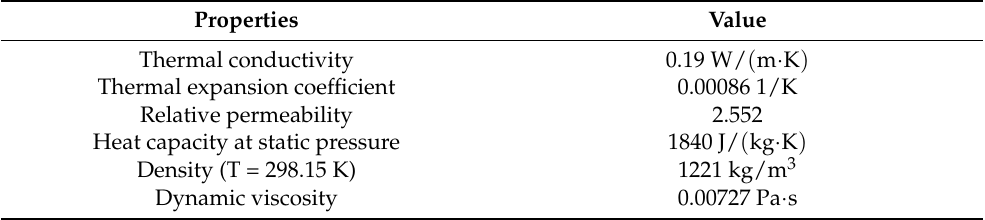
Table 1. The properties of EFH-1